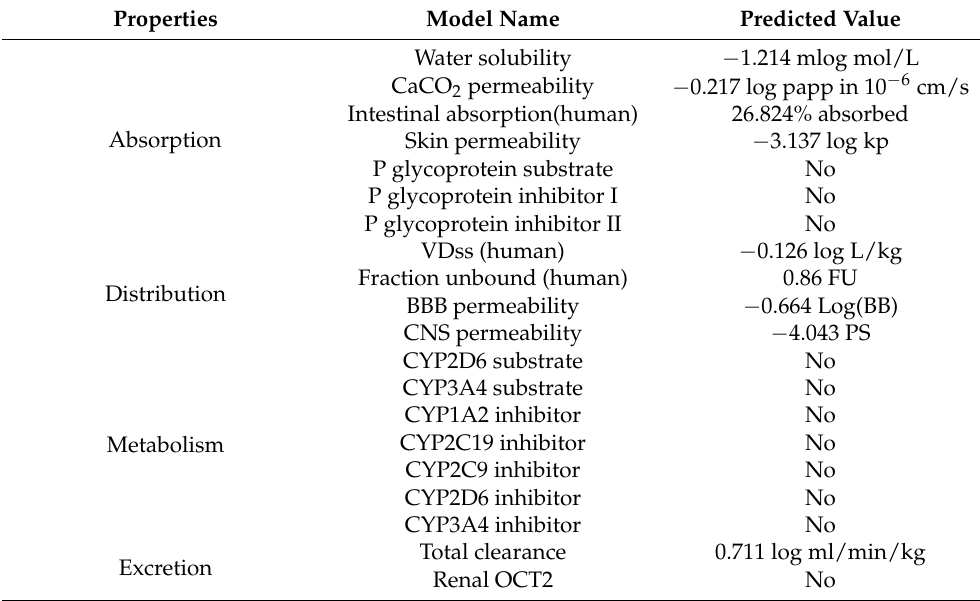
Table 4. In silico ADME properties of 2-acetamido-2-deoxy-hexopyranose. Properties